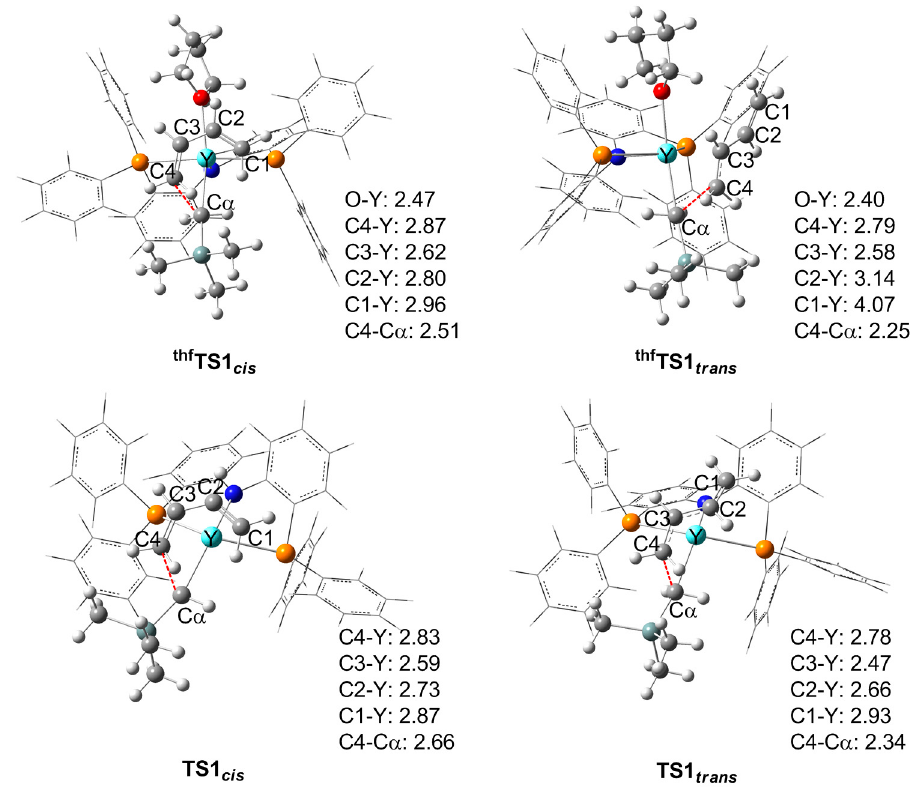
Figure 3. Transition state structures (distances in Å) for the cis - and trans -insertion of butadiene into the Y–alkyl σ -bond of the cationic species thf A or A .